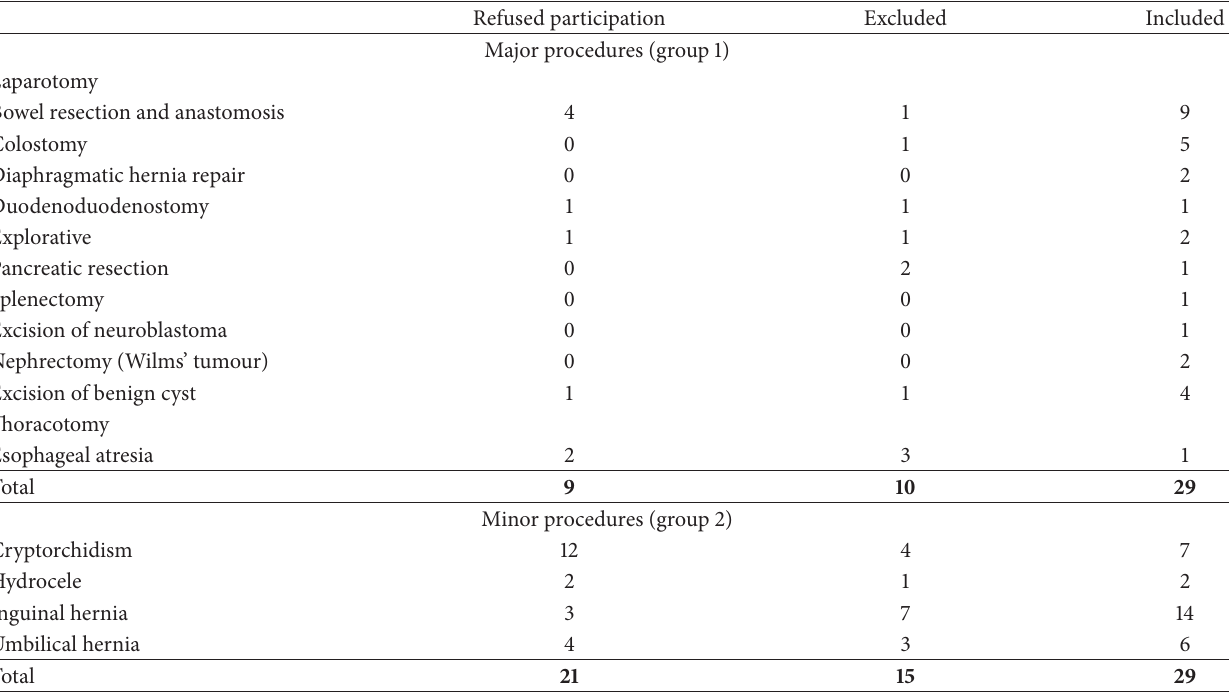
Table 1: Surgical procedures in the two groups.